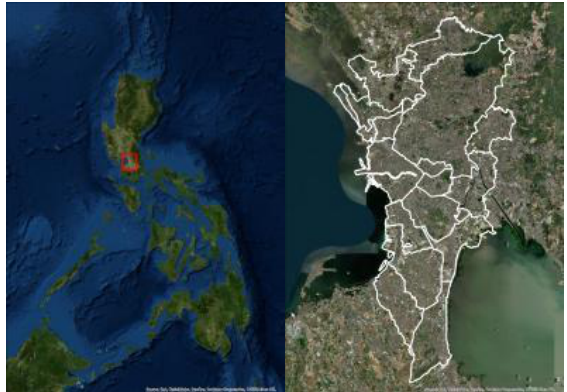
Figure 1. Map of study area (a) Philippines, (b) Metro Manila.